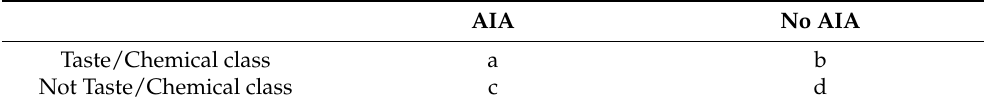
Table 5. The 2 × 2 table used for performing Chi-square test (AIA = anti-inflammatory activity). AIA No AIA Taste/Chemical class a b Not Taste/Chemical class c